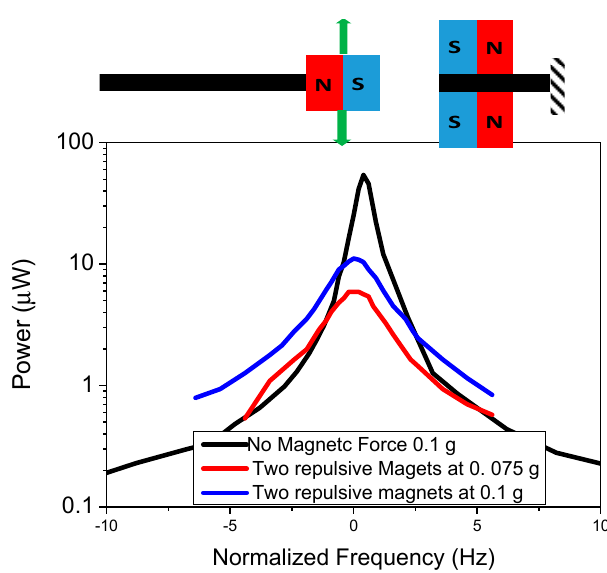
Figure 9. Experimental results of in-plane two-tethered configuration for repulsive magnets at varying acceleration.